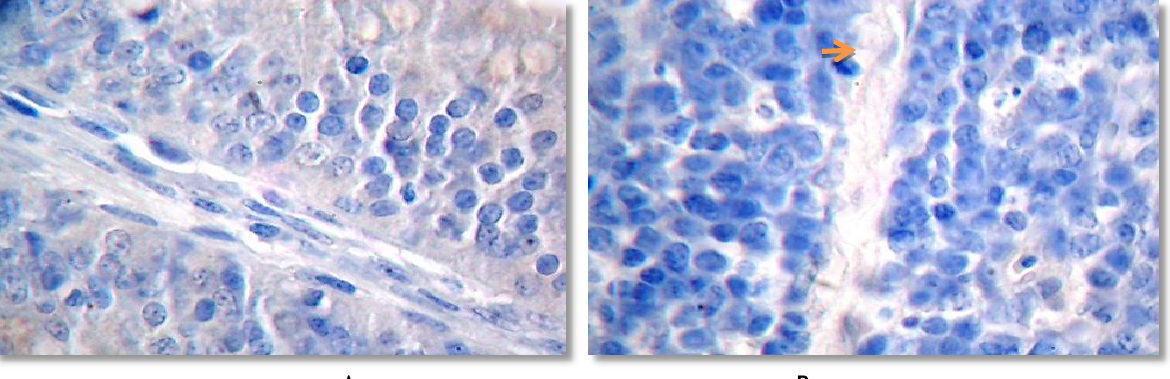
A B Figure,3-A:Immunohistochemical staining of duodenum in heat stressed non treated 14 days old chick G2 , paraffin embedded sections (5µm) appears no stained cells.B:Immunohistochemical staining of the bursa of fabricius in heat stressed non treated 14 days old chick G2, the paraffin embedded section (5µm) appears no stained cells. 100 x.